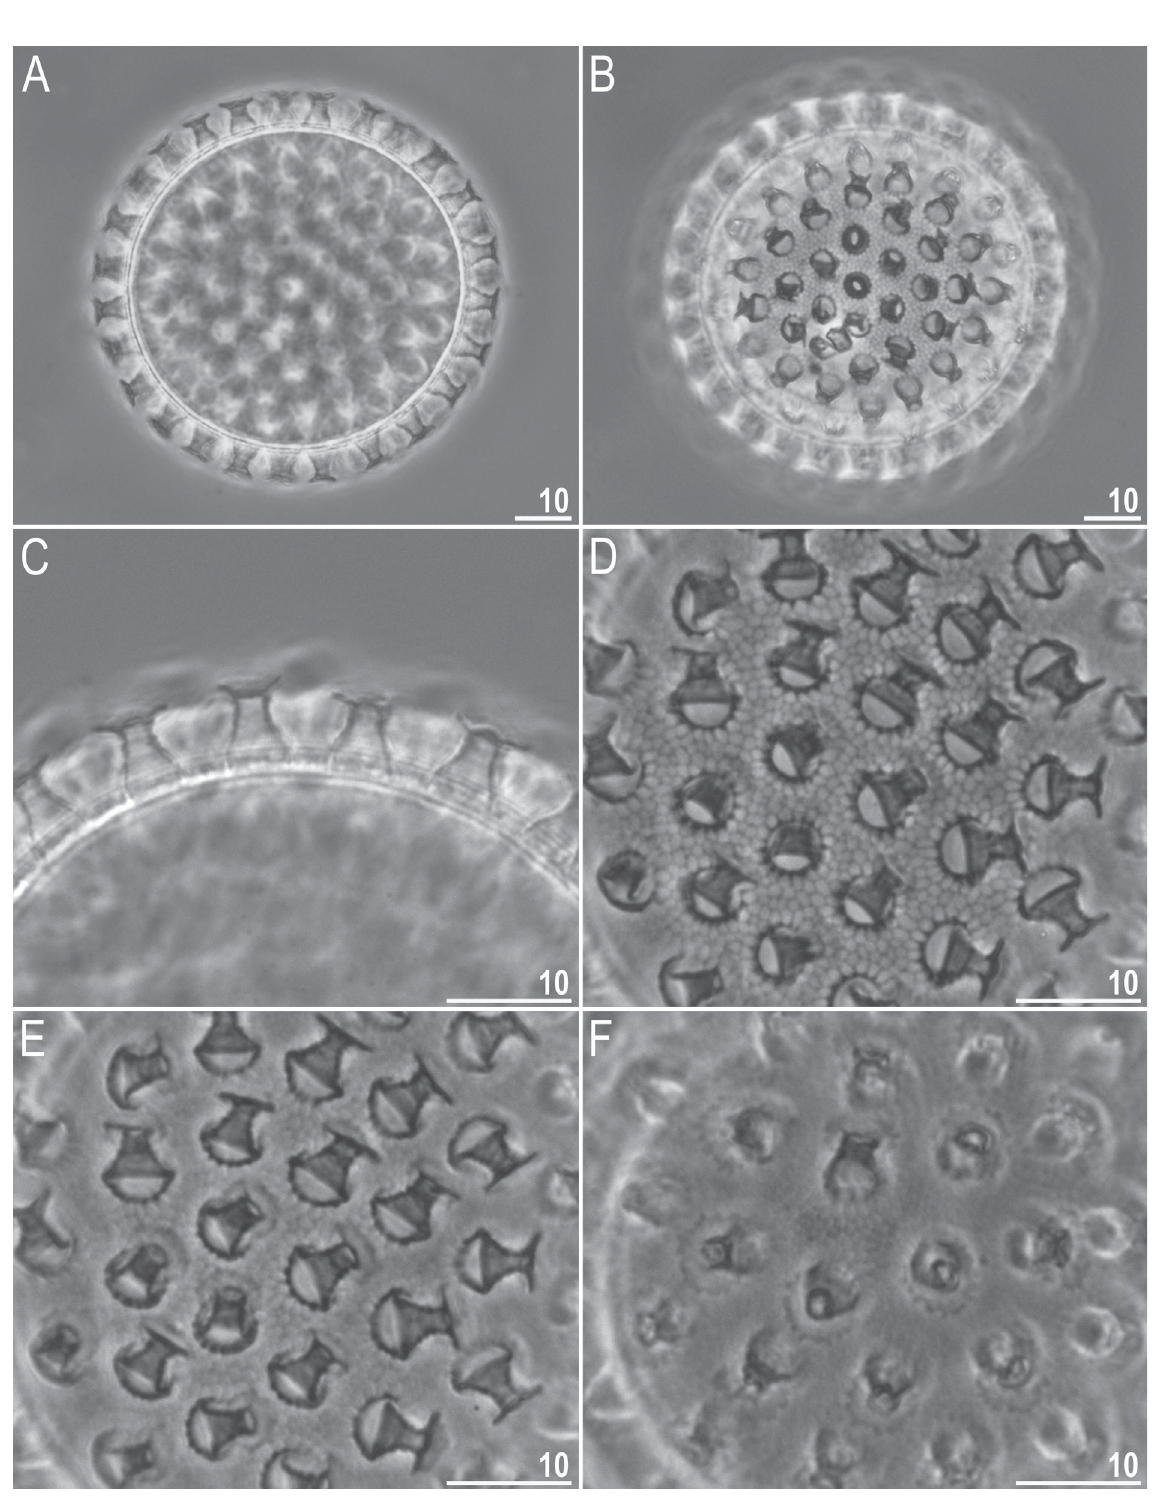
Fig. 6. Macrobiotus canaricus sp. nov., egg seen under PCM. A . Midsection under 400 × magnification. B . Surface under 400 × magnification. C . Midsection under 1000 × magnification. D–E . Surface under 1000 × magnification. F . Outlines of terminal discs of egg processes under 1000 × magnification. Scale bars in